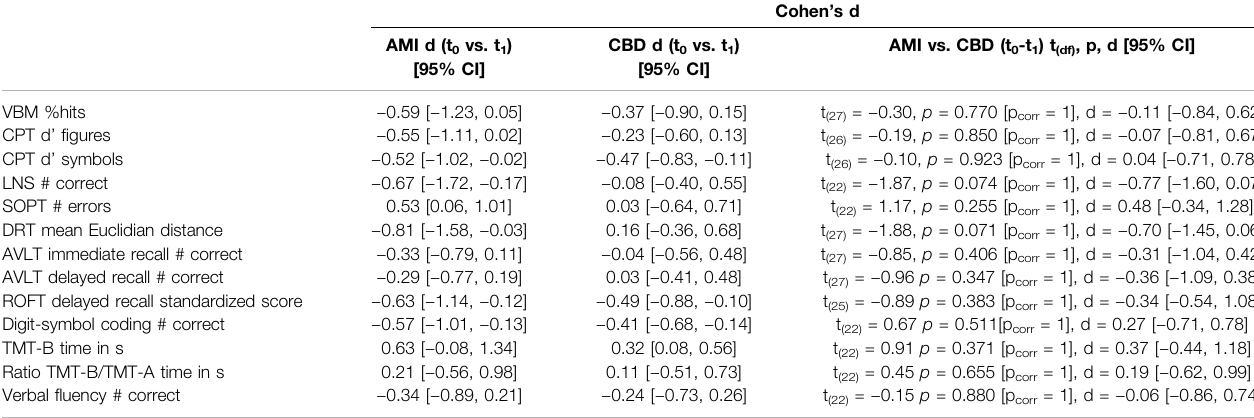
TABLE 3| Effectsize(Cohen ’ sd)forchangesinneurocognitivetest scores(t 0 -t 1 )and independentt-test results,toassess theequalityoftheeffect sizes.Improvementsare indicated by negative effect sizes except for SOPT (#error), DRT (Euclidian distance), TMT-B, and ratio TMT-B/TMT-A (both times in s).